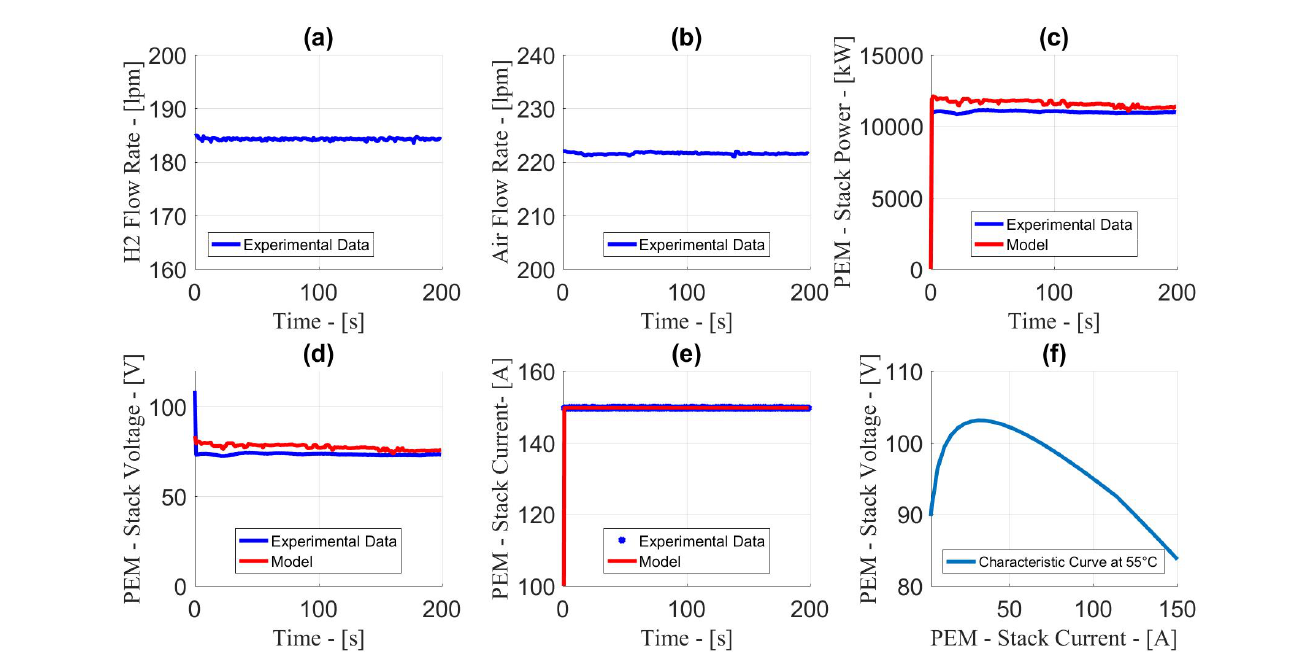
Figure 6. PEM fuel cell validation at 40% of oxidant composition 2 and 1 bar of air pressure. Inputs; ( a ) H 2 flow rate in lpm and ( b ) air flow rate in lpm. Outputs: ( c ) stack power in W with maximum error of 7.5%, ( d ) stack voltage in V with maximum error of 8.7% and ( e ) stack current in A with maximum error of 0.1%, ( f ) I-U characteristic curve.